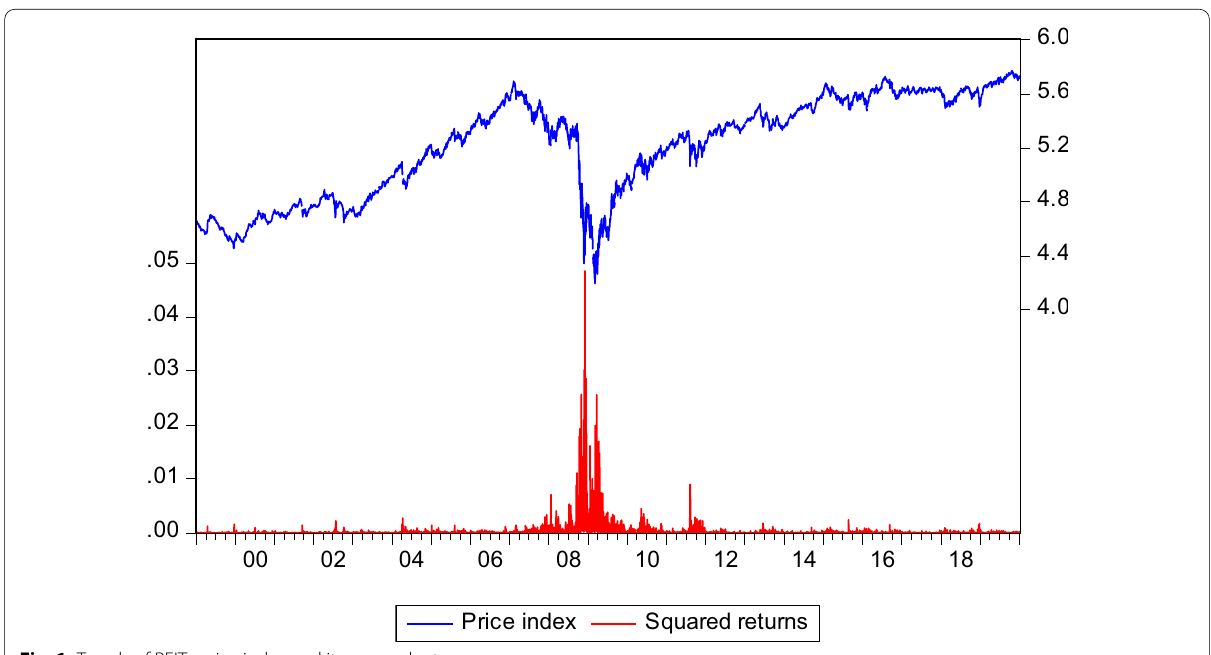
Fig. 1 Trends of REITs price index and its squared